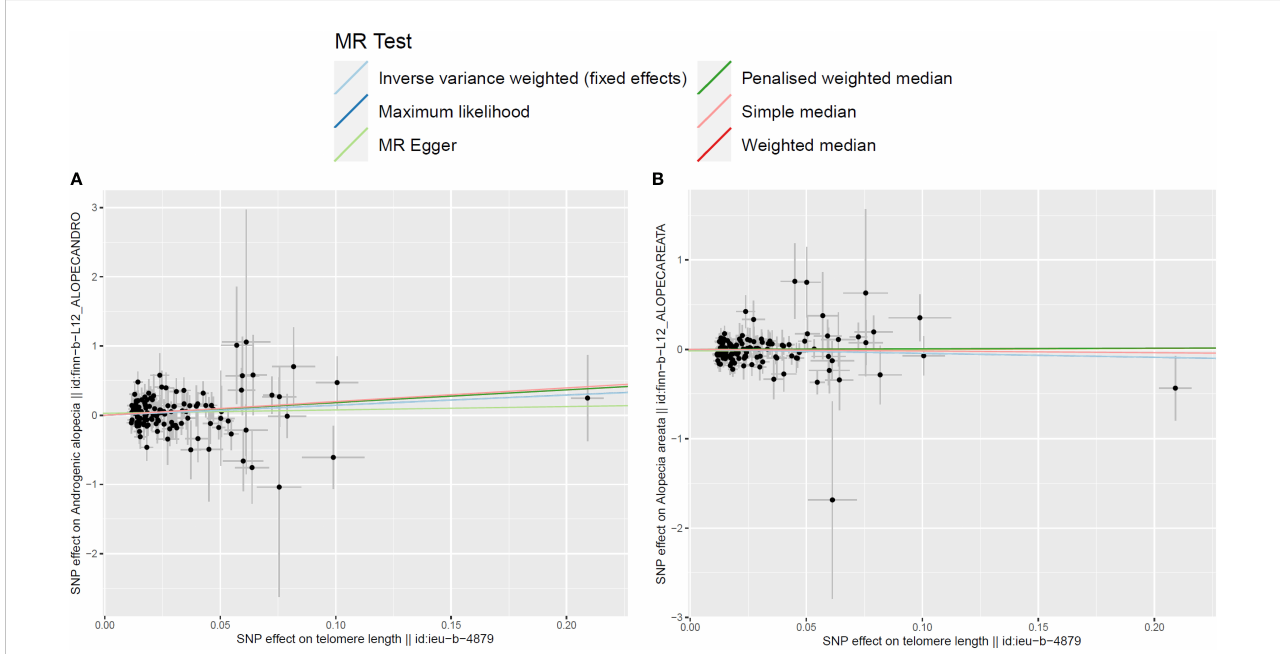
FIGURE 2 Scatter plots for the effects of single-nucleotide polymorphisms (SNPs) on telomere length and non-scarring alopecia. The x-axis represents the effects of each genetic variant on telomere length, and the y-axis represents the effects of each genetic variant on androgenetic alopecia (A) or alopecia areata (B) .